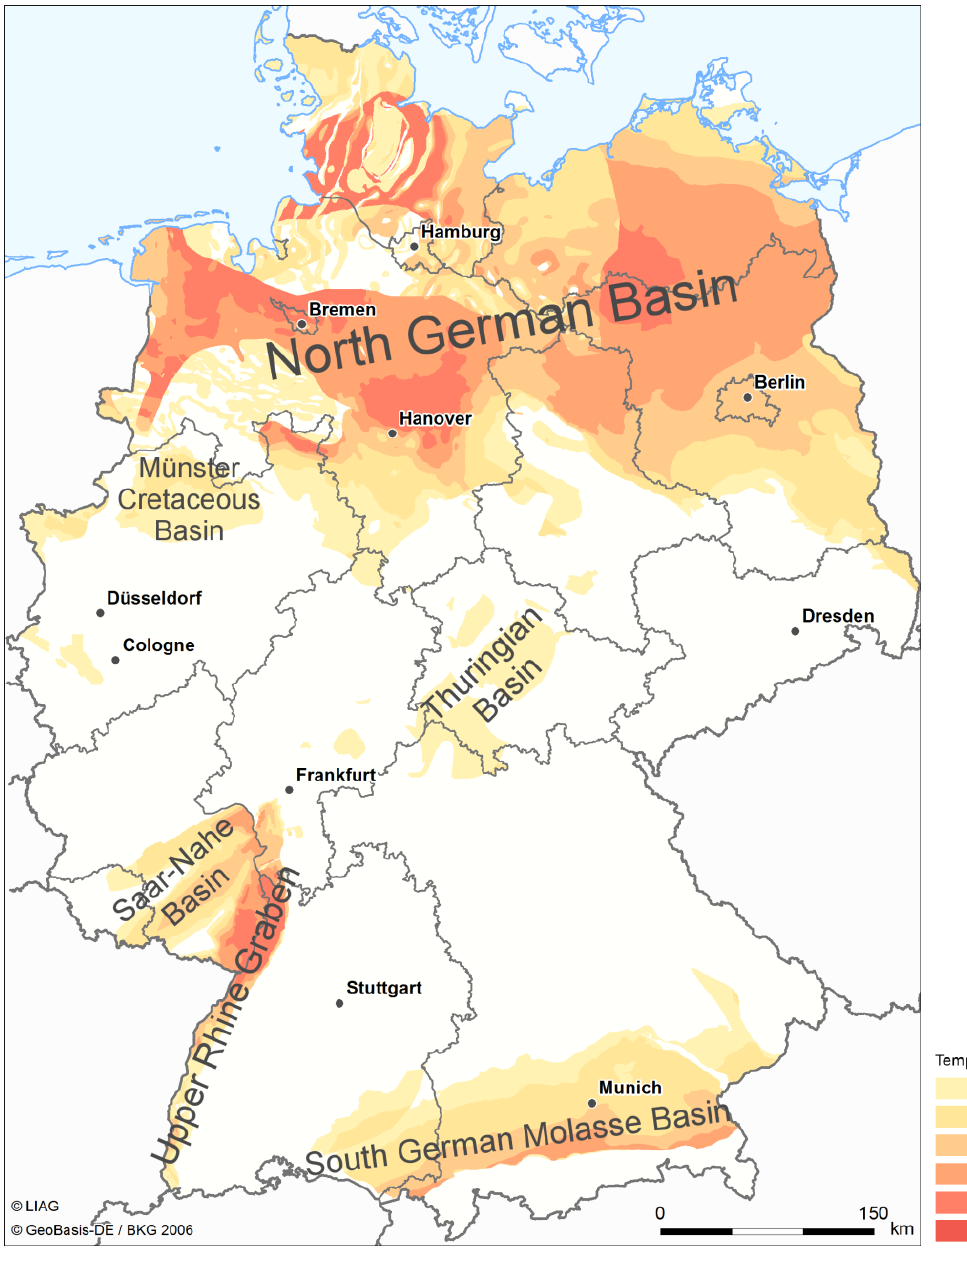
Figure 2. German regions with hydrothermal resources (proven and assumed) and associated temperature ranges. Map adapted from Suchi et al. [5] (copyright 2014 Leibniz Institute for Applied Geophysics